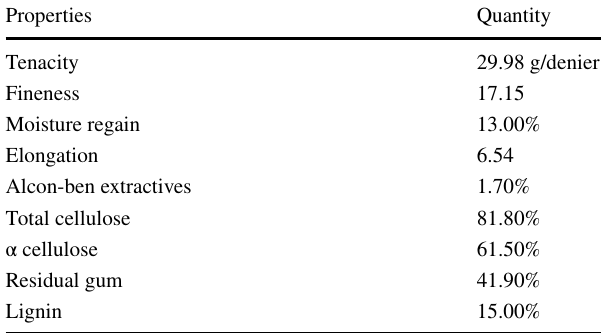
Table 1 Basic properties of banana fiber (Ferdus Alam